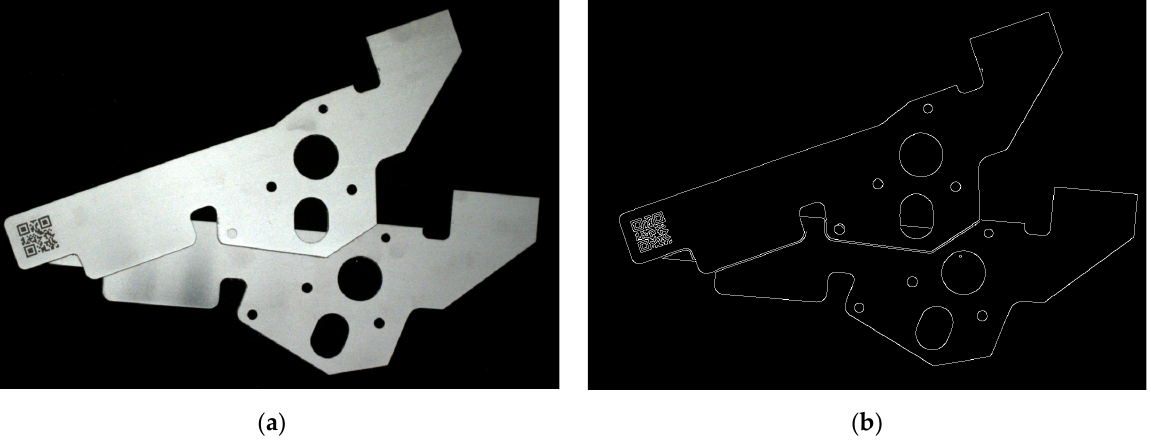
Figure 16. Image of parts’ edges detected by the Canny algorithm: ( a ) stacked sheet metal parts; ( b )